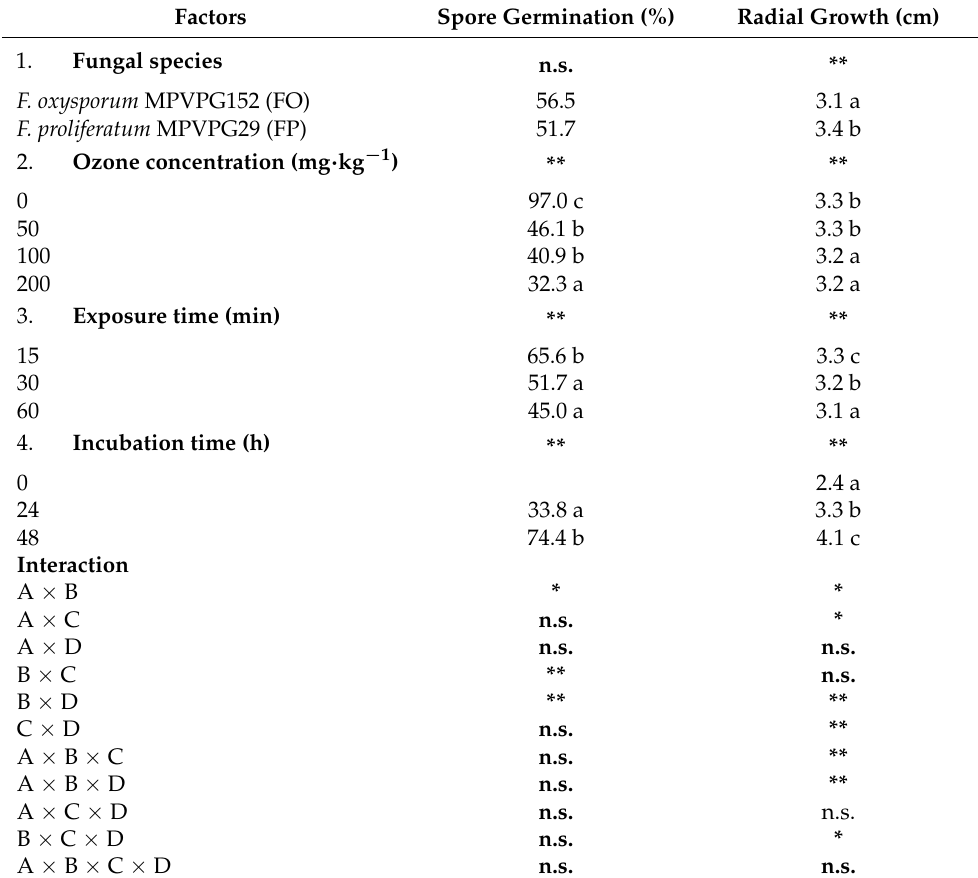
Table 1. Analysis of variance of spore germination (%) and radial growth for the two Fusarium species tested on GM plates at the end of the in vitro trial with ozone. Plates were exposed to different ozone concentrations (0, 50, 100 and 200 mg · kg − 1 ) for 15, 30 or 60 min and then incubated for 0, 24 or 48 h. Different letters indicate significant differences according to Tukey’s test ( p < 0.01). Factors Spore Germination (%) Radial Growth (cm) 1. Fungal species